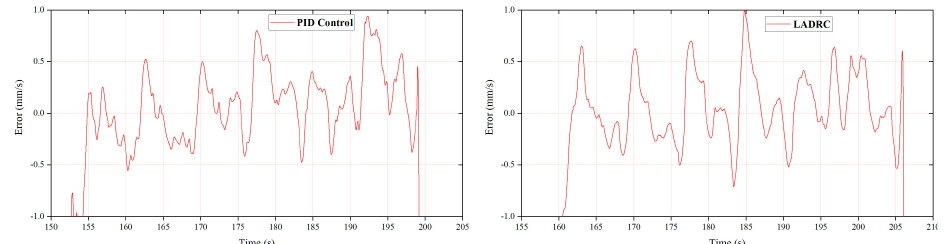
Figure 32. Speed error of cylinder #6 during unfolding.